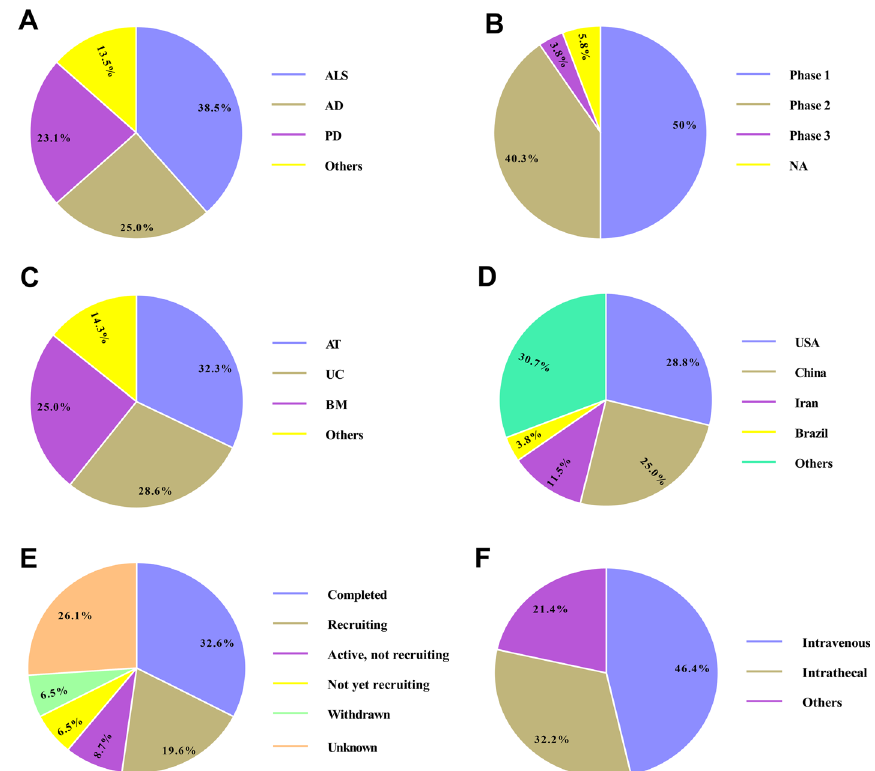
Fig. 3 Clinical trials based on mesenchymal stromal cell (MSC) therapy in common neurodegenerative diseases registered on ClinicalTrials.gov (April 2022). The schematic demonstrates clinical trial according to condition ( A ), phase ( B ), MSC source ( C ), study location ( D ), study status ( E ), and administration rote ( F